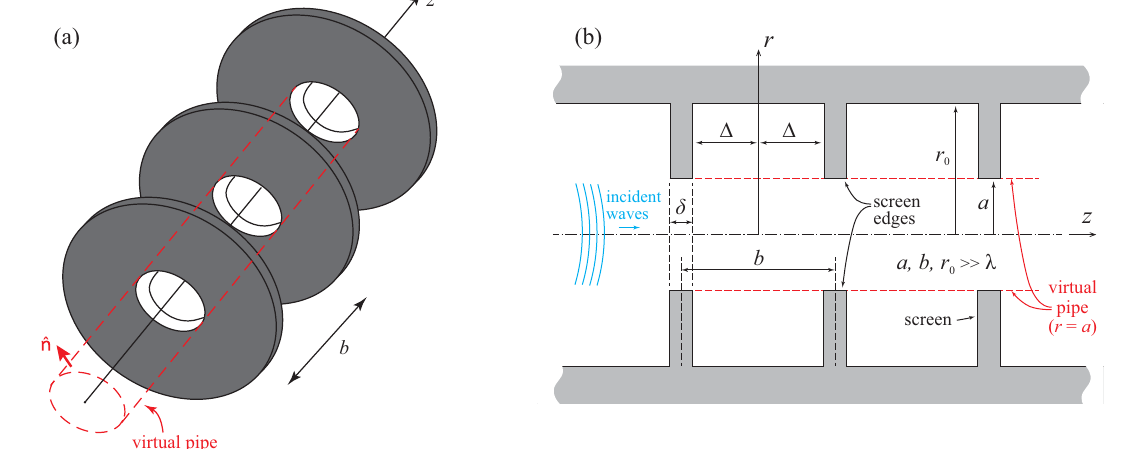
FIG. 1. (a) The iris-line geometry in three dimensions, showing the screens without the enclosing chamber at the outer radius. (b) A cross section in the iris line, showing the enclosing